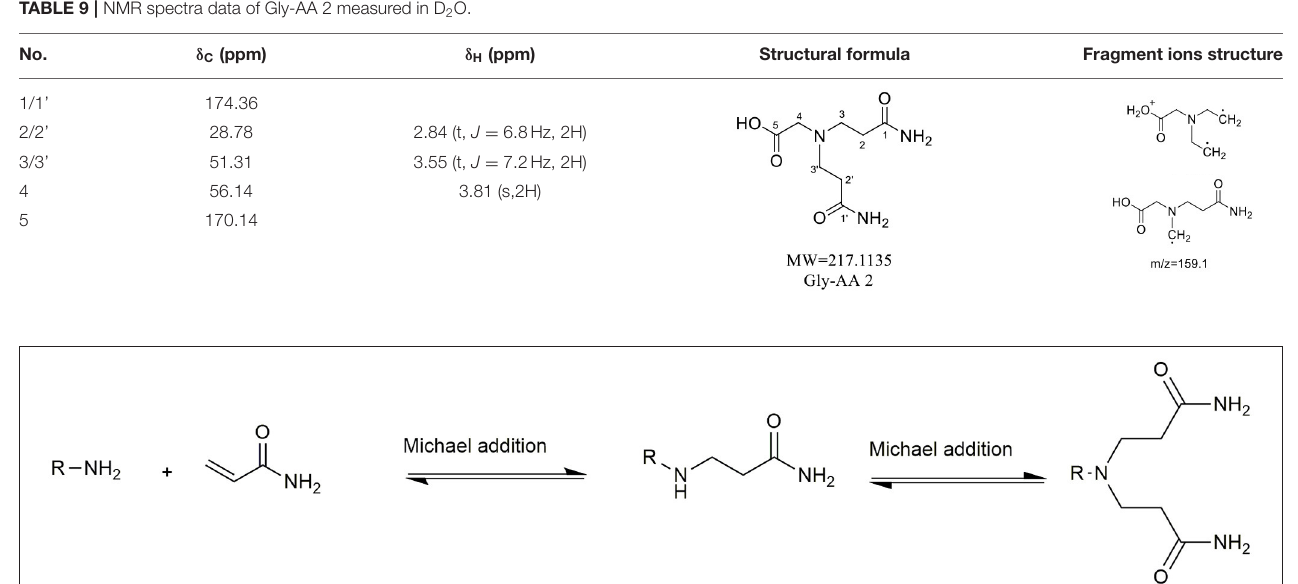
FIGURE 4 | Supposed formation scheme for of amino acids-acrylamide adducts.